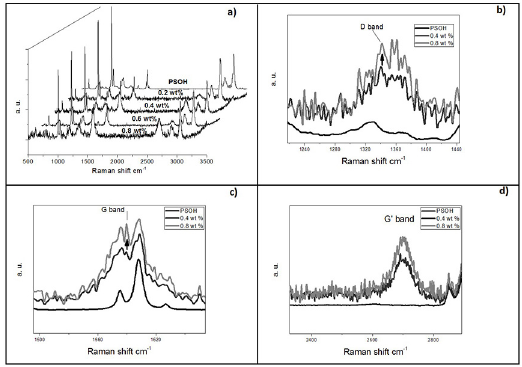
Figure 5. Raman spectra: a) PSOH and composites, b) D band appearance, c) G band appearance and displacement, d) G’ band appearance and